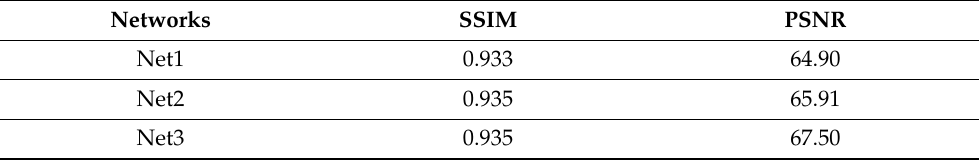
Table 3. The quantitative results on different networks based on SSIM.